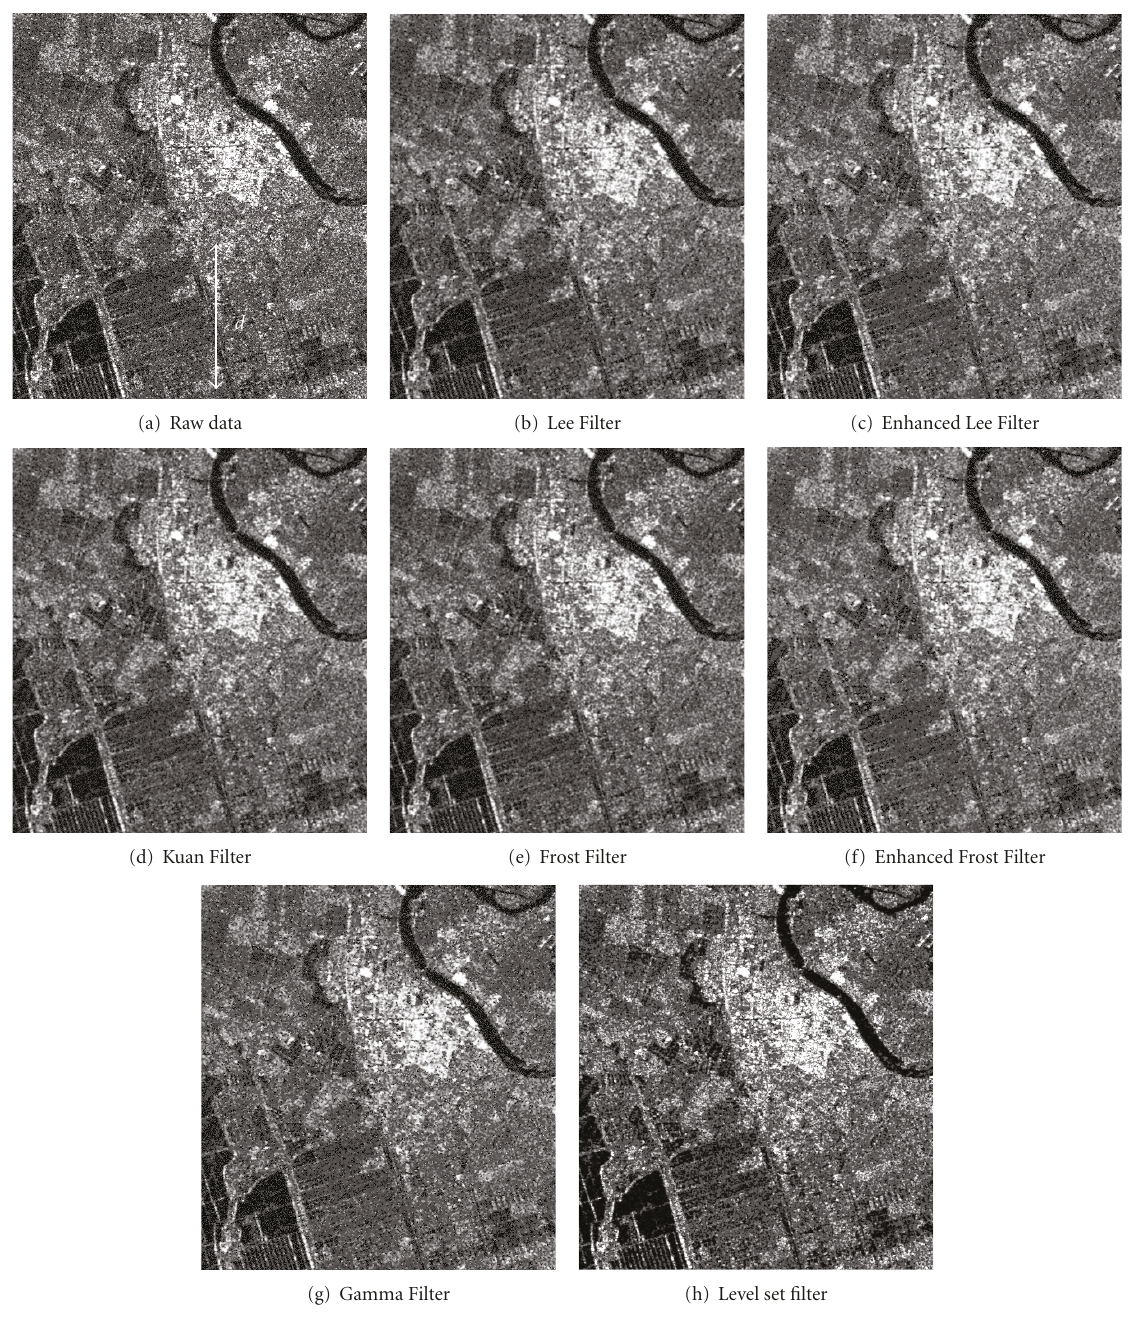
Figure 4: The proposed level set-based filter in contrast to the conventional approaches of landscape ERS-2 SAR image.